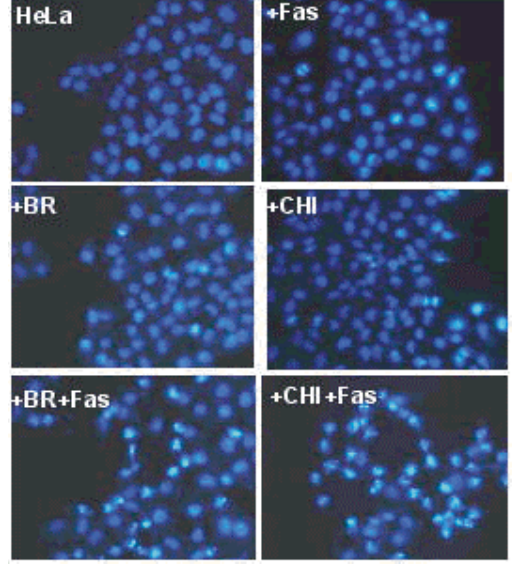
Fig. 1. The pretreatment of HeLa cells with brefeldin A or cycloheximide makes them more sensitive to Fas-specific apoptosis.